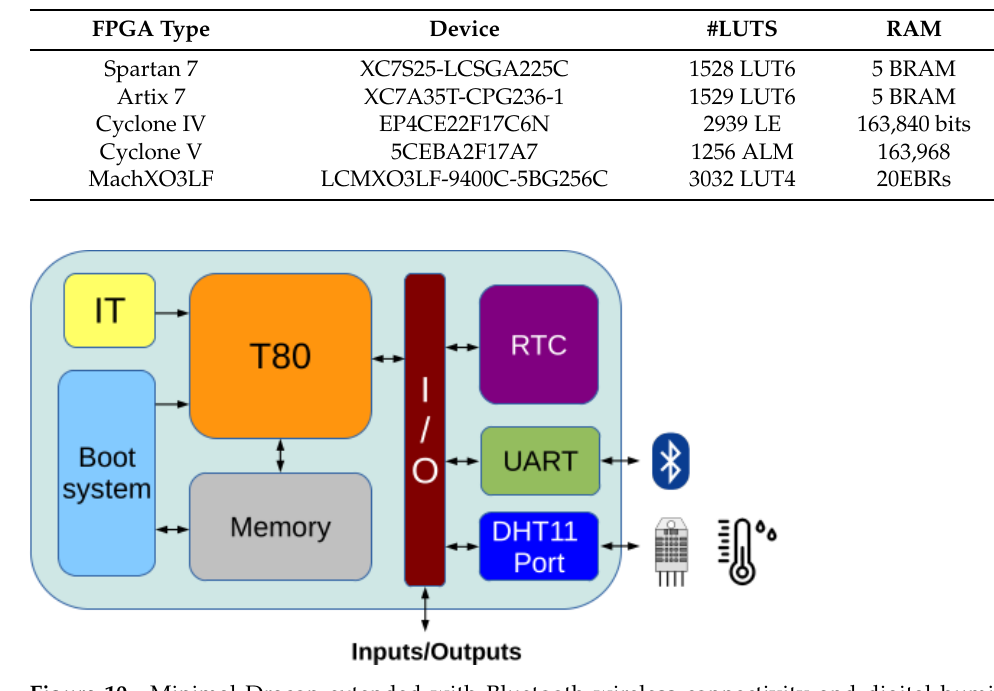
Table 4. Minimal Dracon with DHT11 sensor support implementation results.